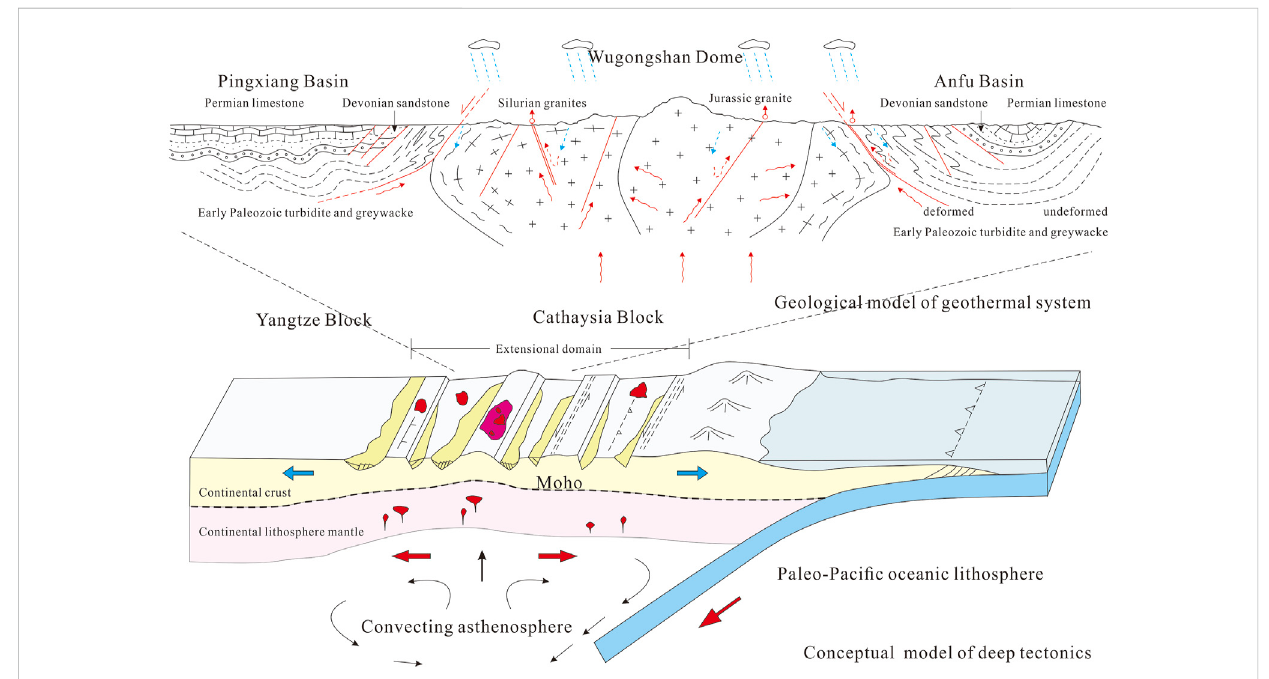
FIGURE 13 Genetic model map of geothermal resources in the Wugongshan area (modi fi ed from Shu et al., 1998; Li et al.,